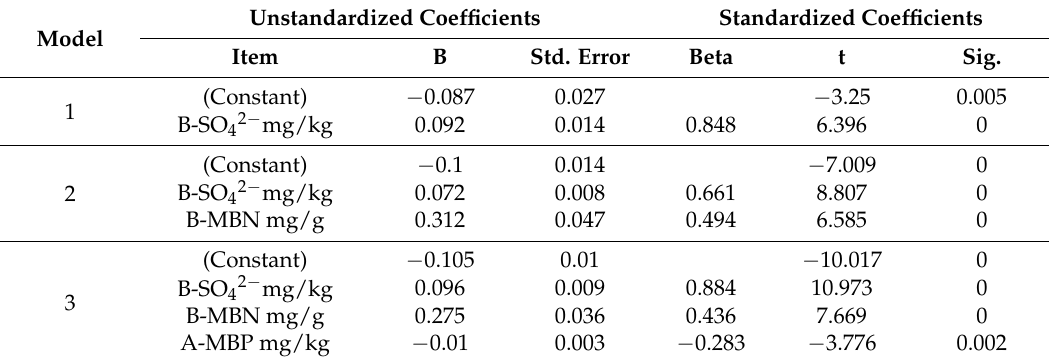
Table 6. The standard multiple regression coefficient of main factors affecting sediment phosphorus release